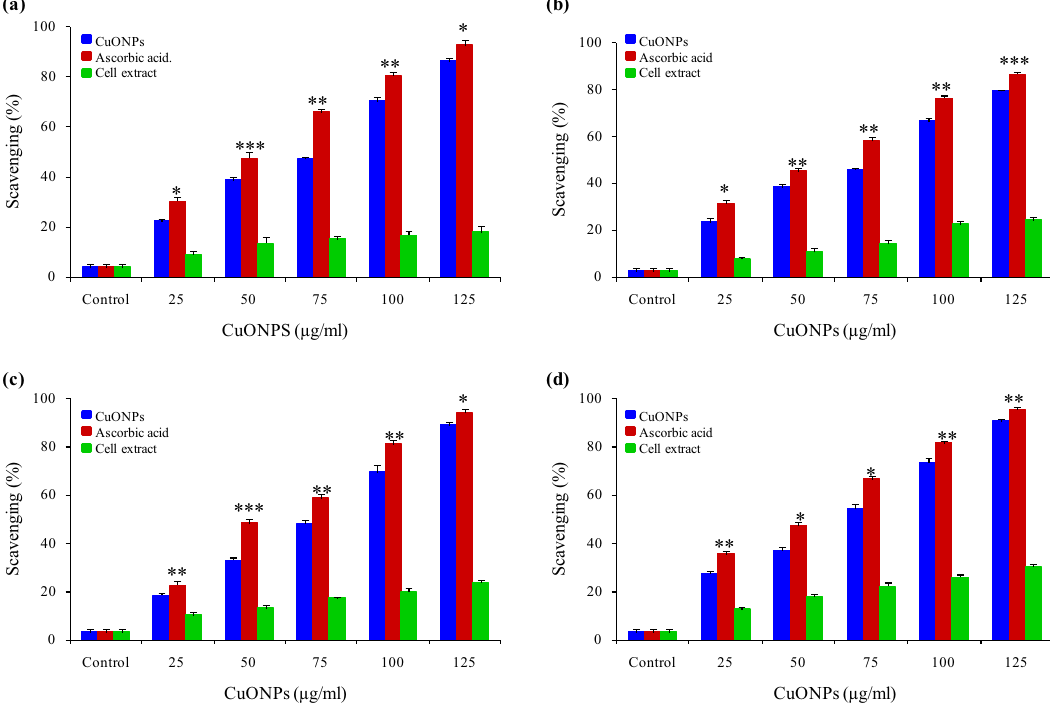
Figure 3. Antioxidant activity of cell free extract, biogenic CuONPs and ascorbic acid by different scavenging assays; ( a ) ABTS; ( b ) DPPH; ( c ) Hydrogen peroxide; ( d ) SOR. Experiments were performed in triplicates; bars represent the mean of values and error bars represent mean ± SD (* P < 0.05).